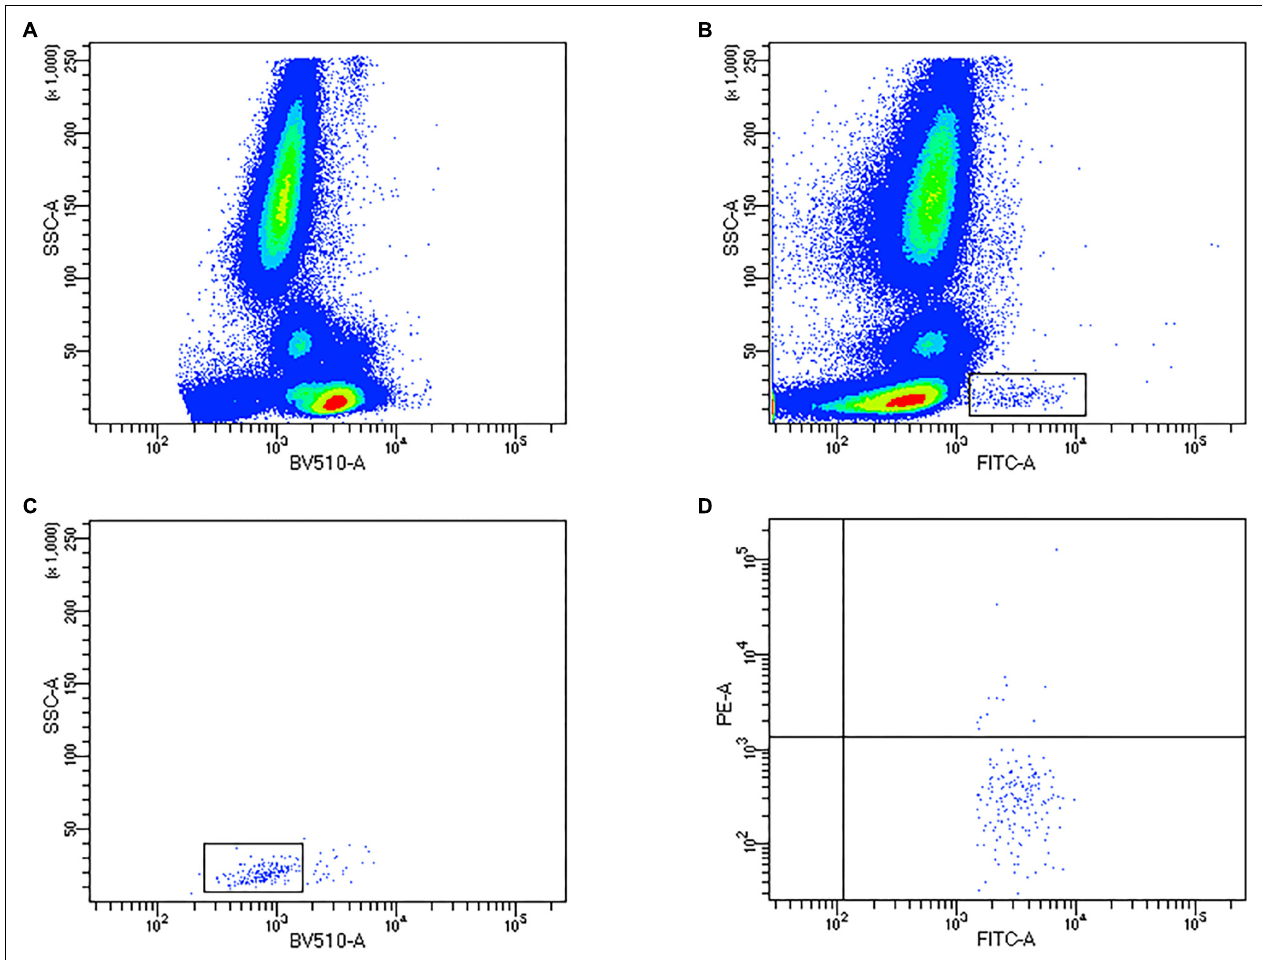
TABLE 2 | Circulating leukocyte changes in response to blood flow restricted (BFR) and non- Restricted (non-BFR) Exercise ( n = 9). Pre Immediately Post- 30 min Post- Main effect of exercise Time x Trial Interaction